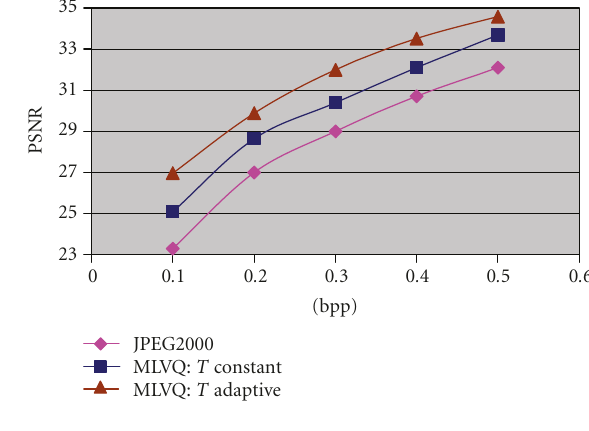
Figure 8: Test image “goldhill.”